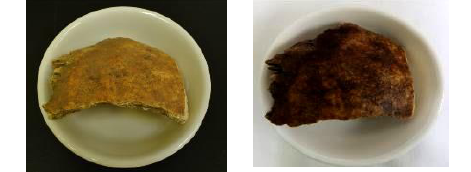
Figure 13. Absolutely dry human bone sample (left); mixed with water human bone sample (right).